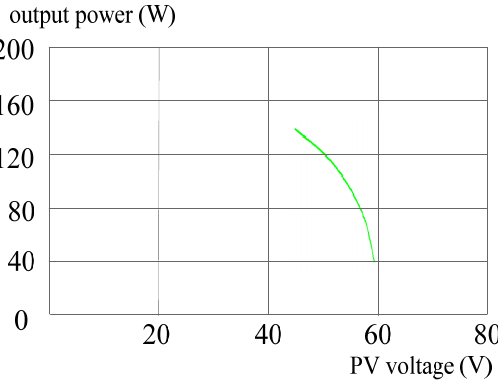
Figure 15. MPPT trajectory by the DALL while irradiation and temperature increase.